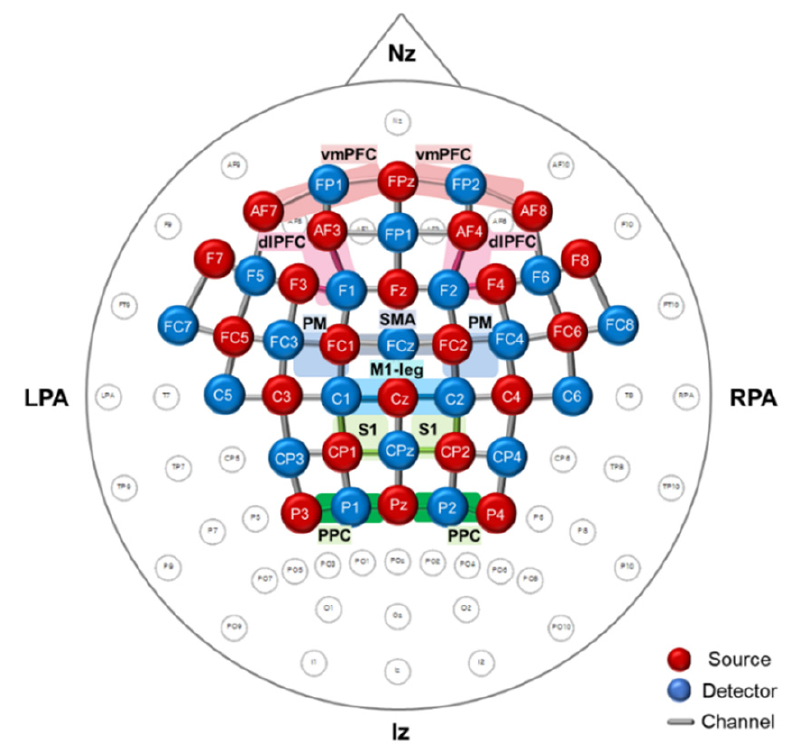
Figure 1. Position of functional near-infrared spectroscopy (fNIRS) measurement optodes and chan- nels. In the fNIRS channel arrangement, 22 sources and 21 detectors covered the cortical areas of the bilateral M1-leg, PM, SMA, S1, PPC, dlPFC, and vmPFC using 71 channels of interest. LPA, left pre-auricular points; RPA, right pre-auricular points; Nz, nasion; Iz, inion; M1-leg, primary leg motor cortex; PM, premotor area; SMA, supplementary motor area; S1, primary somatosensory cortex; PPC, posterior parietal cortex; dlPFC, dorsolateral prefrontal cortex; vmPFC, ventromedial prefrontal cortex.